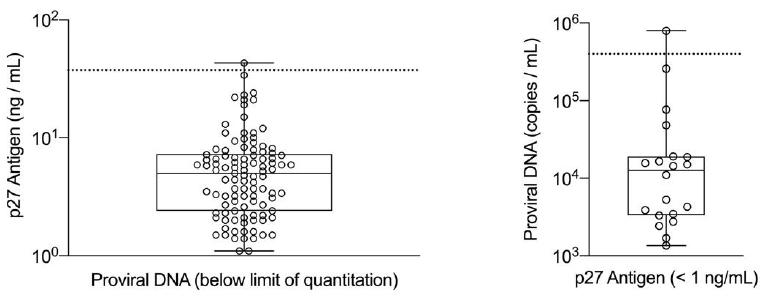
Figure 2. Samples with discordant qualitative test results are graphed separately for p27 antigen positive/proviral DNA negative ( left , n = 105) and for p27 antigen negative/proviral DNA positive ( right , n = 20). Cutoff values from the ROC analysis are represented by horizontal dashed lines at 37.5 ng/mL of p27 antigen ( left ) and 4.0 × 10 5 copies/mL for proviral DNA ( right ).